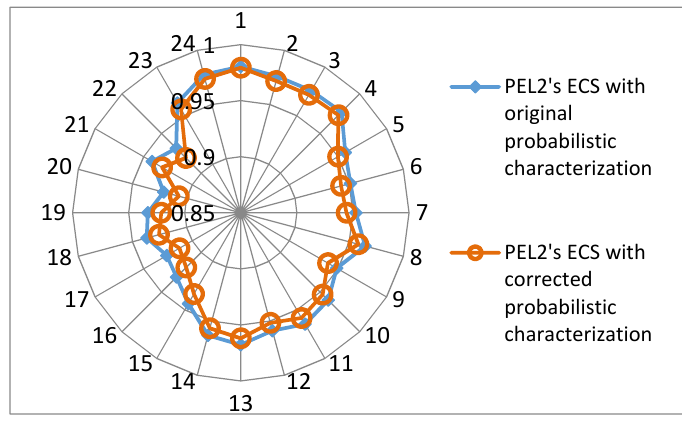
Figure 12. Electricity consumption satisfaction (ECS) of PEL 2 with changing k .